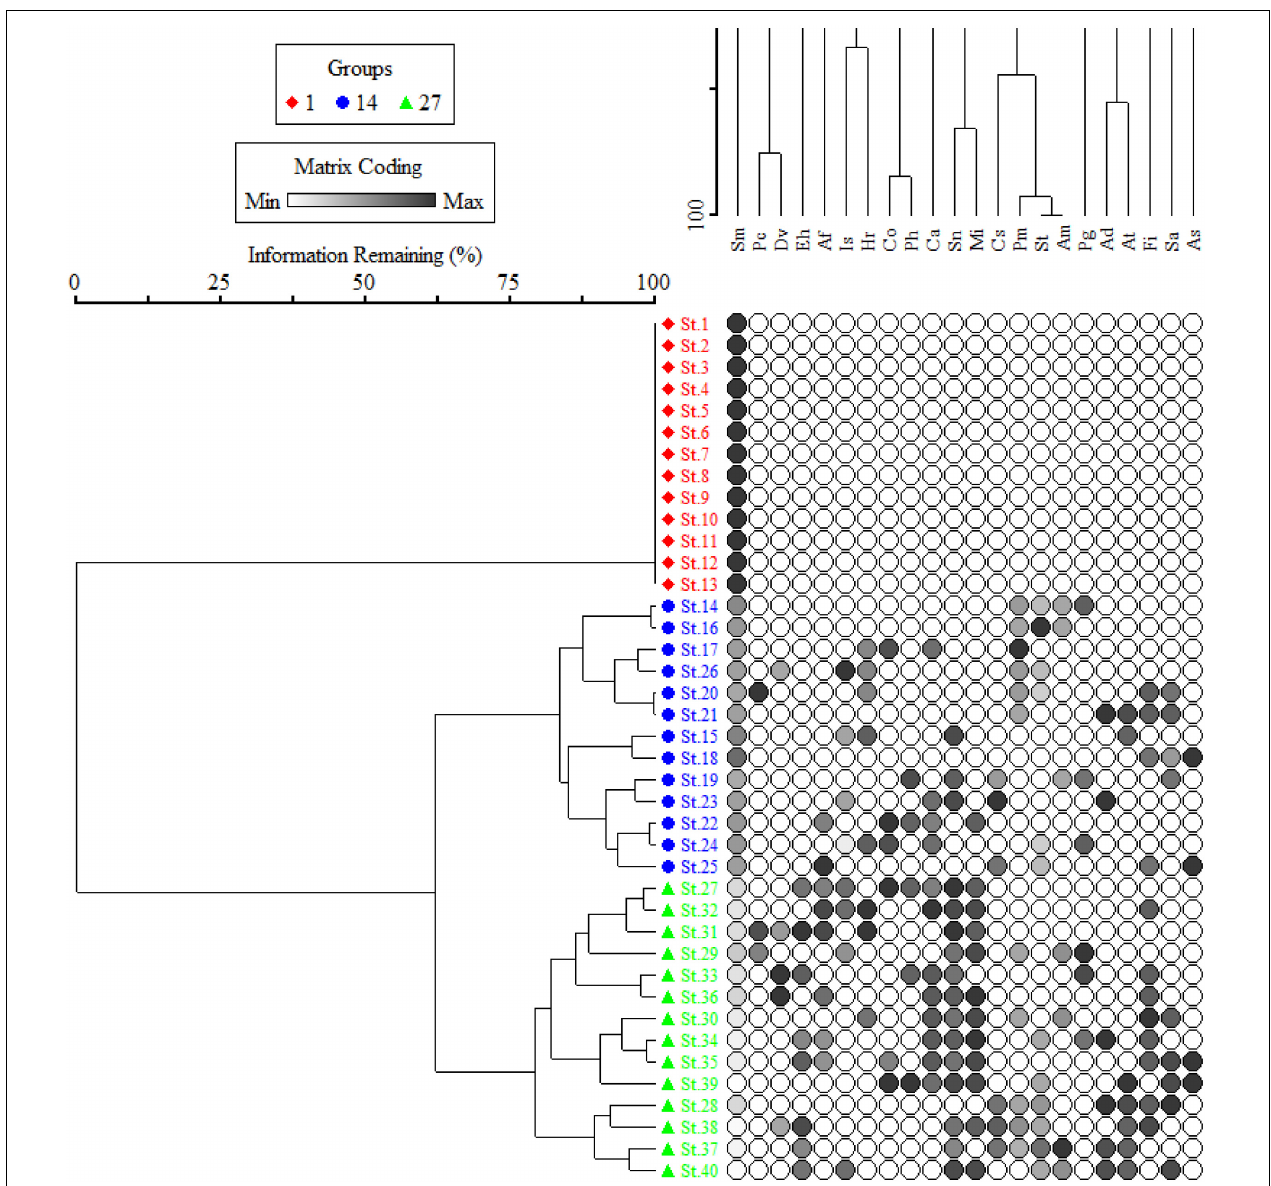
FIGURE 2 | Cluster dendrogram separating 40 stands of Silybum marianum ( S. marianum ) across the invasion